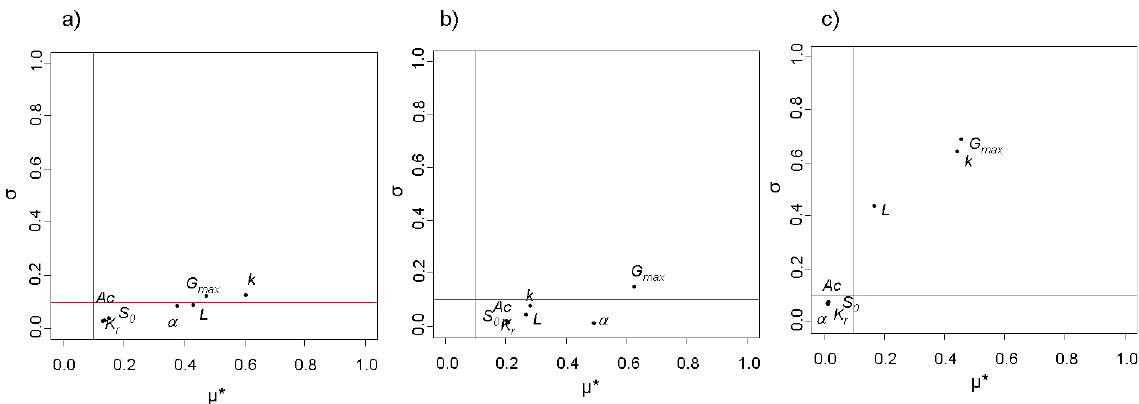
Fig. 8. Results of the Morris OAT sensitivity analysis for three model outputs: (a) cumulated water height, (b) maximum water height and (c) occurrence of the first peak in water height. The graph represents the average of elementary effects in absolute values ( µ *) according to their standard deviation ( σ) to model outputs. The red lines delimit the space in three types of parameters: i) those with negligible effects ( µ * < 0.1), ii) those with linear effects on the output, and without interaction between parameters ( σ< 0.1), iii) those with interactions and/or nonlinear relationship ( µ ∗ > 0.1 and σ >